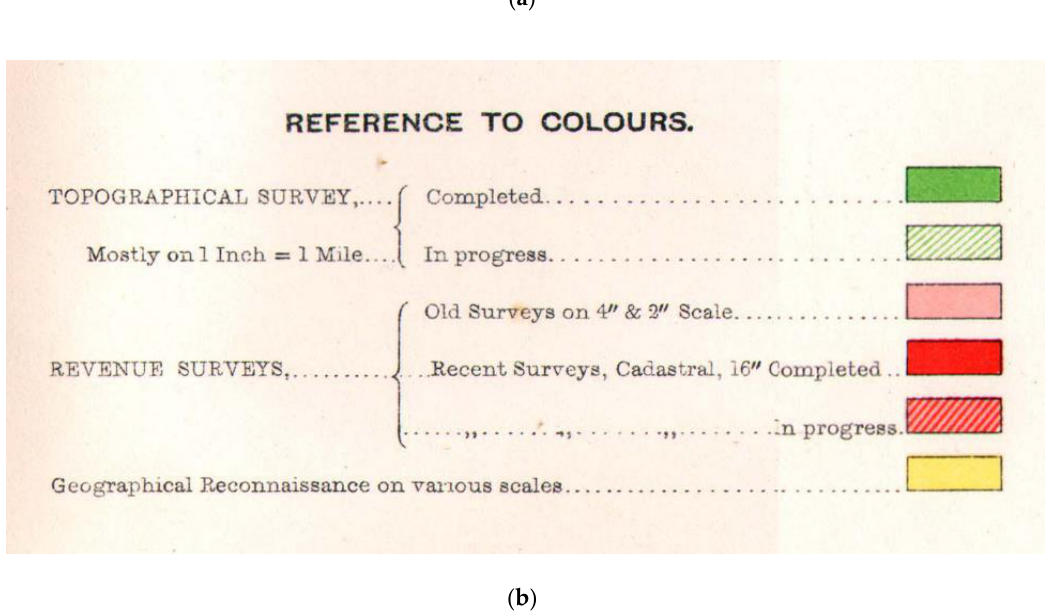
Figure 1. ( a ) Map showing progress of imperial surveys up to 1 st October 1904 (Image: Pahar.in; Public Domain [66]). ( b ) Close-up of the legend from the same map (Image: Pahar.in; Public Domain [66]).